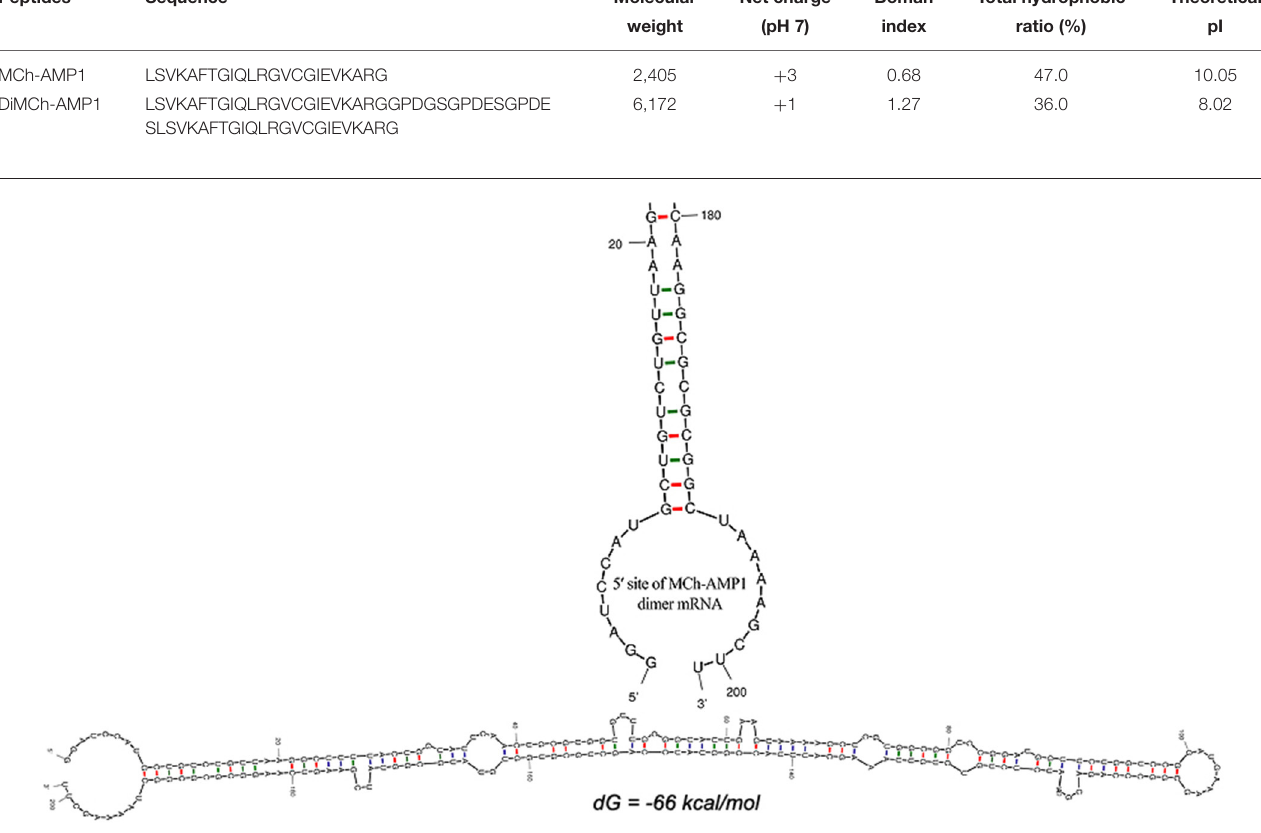
FIGURE 2 | Secondary structure prediction by mfold server shows the optimal mRNA secondary structure of DiMCh-AMP1. Predicted structure has no long stable hairpin and pseudo knot at 5 ′ site of mRNA. 1 G = − 66 kcal/mol, mfold tool.